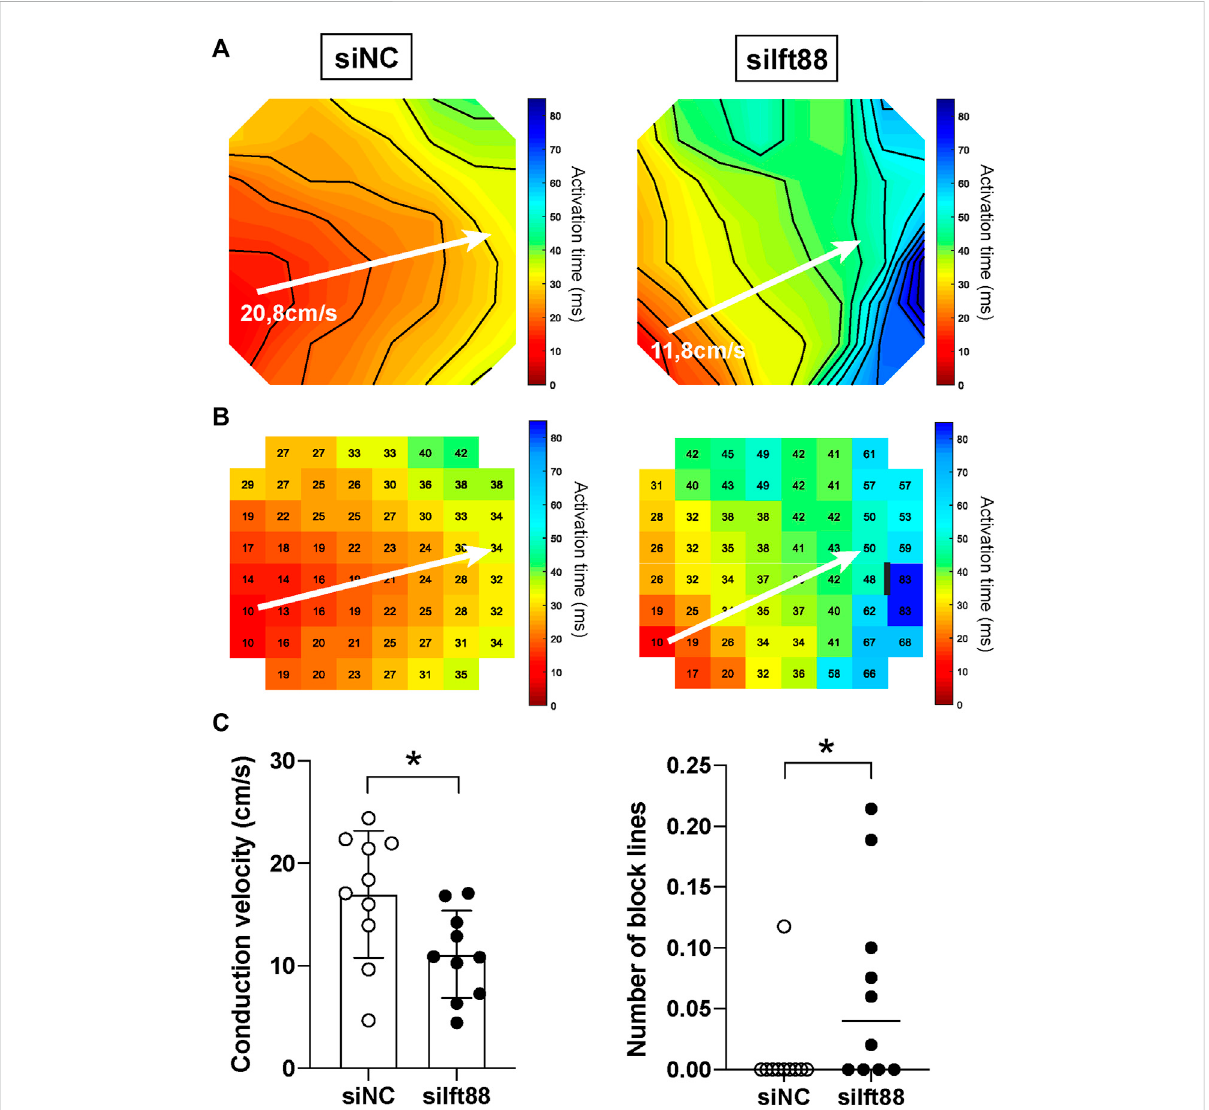
FIGURE 2 Reduced conduction velocity in CM monolayers co-cultured with decreased Ift88 FB. (A,B) Representative activation maps obtained after electrical mapping of spontaneously active CM co-cultured for 48 h with FB previously transfected with siNC or siIft88. Colors indicate activation times, according to the scale at right. Isochrones, 5 ms. White arrows indicate where conduction velocity was measured. Black line indicates 30 ms conduction block. Interelectrode distance of 700 μ M. (C) Conduction velocity (CV) and number of block lines in spontaneously active CM monolayers co-cultured for 48 h with FB transfected with siNC or siIft88. Data are mean ± SD for CV and median for number of block lines, n = 10monolayersfromthreeindependentCM/FBisolation. Student ’ s t -testforCV,Mann-Whitneytestfornumberofblocklines.Factorcorrectionwas carried out on CV to avoid inter-isolations